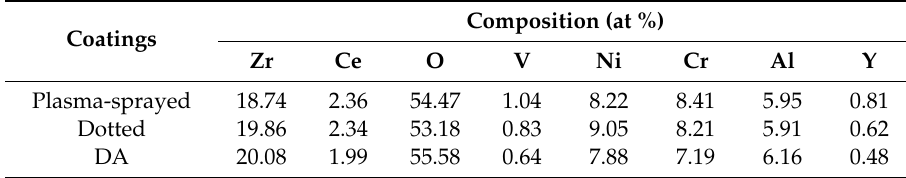
Figure 15. EDS elemental mapping of the cross section of the dotted unit in the DA specimen after the hot corrosion test. Table 4. EDS compositions of plasma-sprayed (Figure 13), dotted (Figure 14), and DA (Figure 15) coatings after the hot corrosion